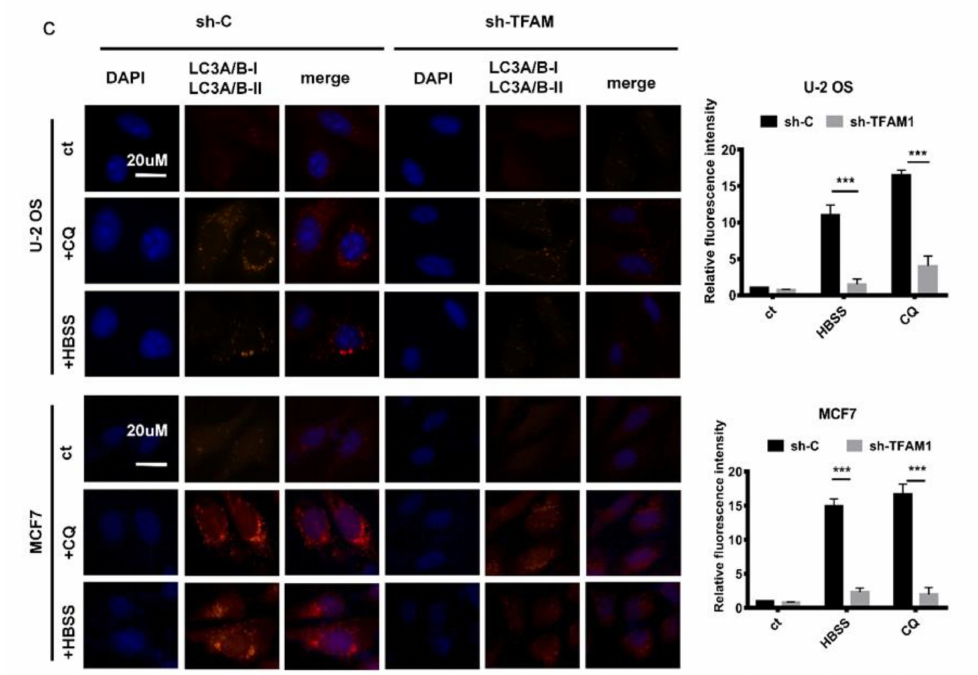
Figure 1. TFAM knockdown inhibits the formation of autophagosome. ( a ) Western blotting analysis of LC3-II levels in TFAM knockdown cancer cell lines. ( b ) The level of LC3-II in control shRNA (sh-C) and TFAM shRNA (sh-TFAM) transfected cells after treatment with 50 µ M CQ or HBSS for three or six hours. ( c ) Immunofluorescence staining of LC3 puncta in sh-C and sh-TFAM cells after treatment with 50 µ M chloroquine (CQ) or HBSS for six hours. Each independent experiment was repeated three times or more, and data are presented as the mean ± SD. * p < 0.05, ** p < 0.01, *** p <